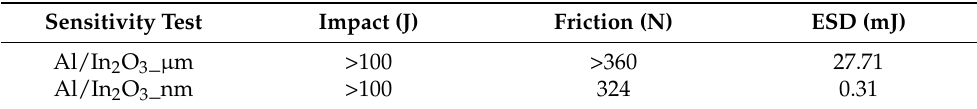
Table 3. Sensitivity thresholds of the aluminum/indium (III) oxide energetic composite materials (at an equivalence ratio φ of 1) as a function of the oxidizer particle